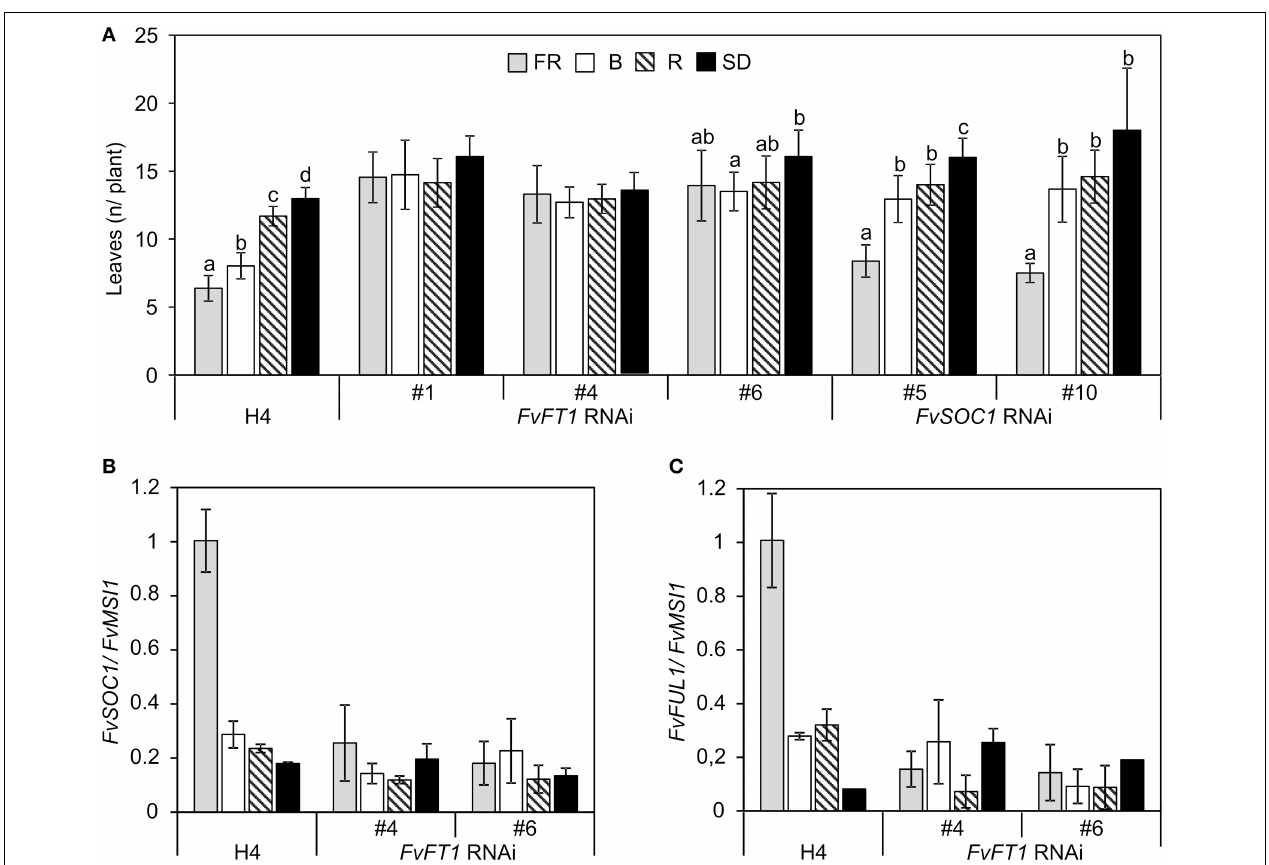
FIGURE 3 | RNAi silencing of FvFT1 and FvSOC1 affects the regulation of flowering by light quality in the perpetual flowering F. vesca accession Hawaii-4 (H4). (A) Flowering time of H4, and FvFT1 and FvSOC1 RNAi lines in different end-of-day light quality treatments indicated as the number of leaves in the primary leaf rosette before the terminal inflorescence ( n = 11–23 for FvFT1 RNAi lines, n = 28–30 for H4, n = 13–18 for FvSOC1 RNAi-5, n = 5 for FvSOC1 RNAi-10). Flowering results were subjected to Two-Way ANOVA ( p < 0 . 001 for each treatment, genotype, and treatment × genotype interaction). Pairwise comparisons were carried out for every